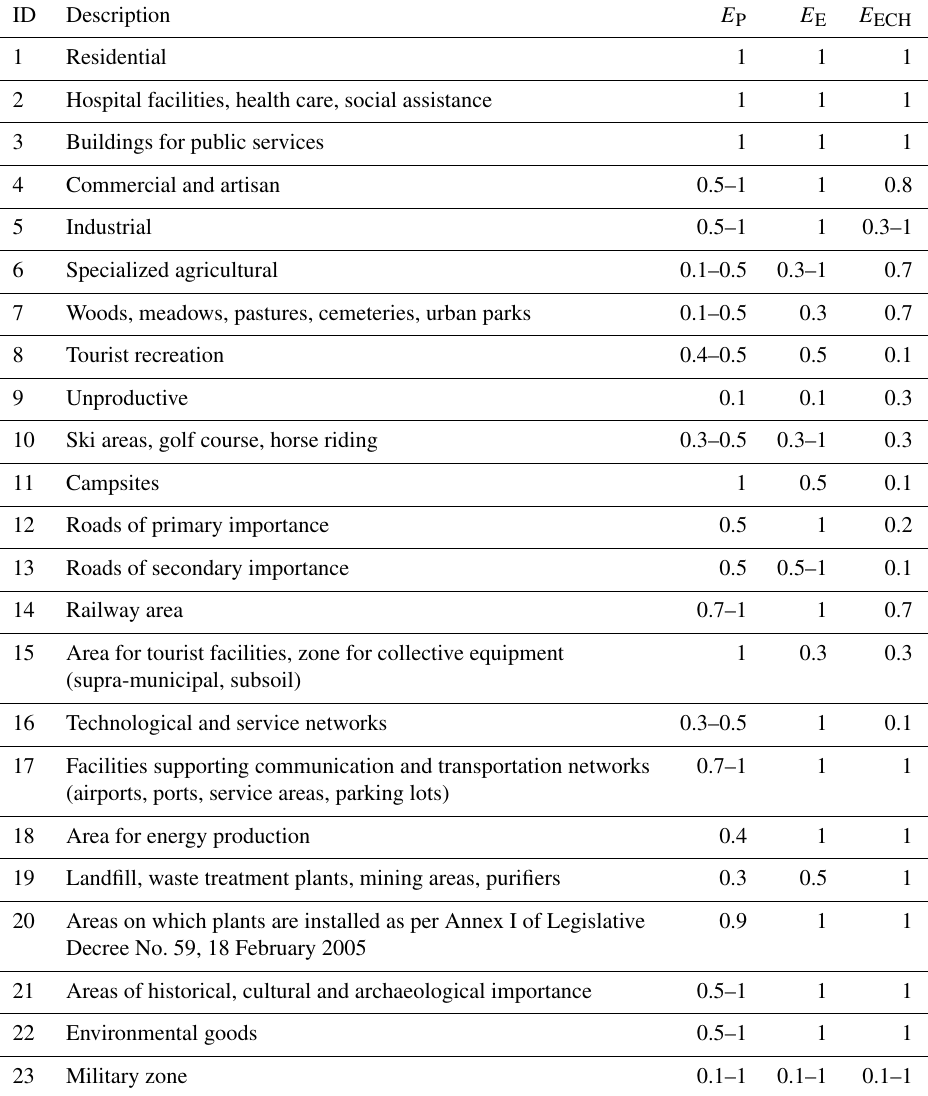
Table 3. The relative values of exposure for people, economic activities and environmental and cultural assets by land use class.